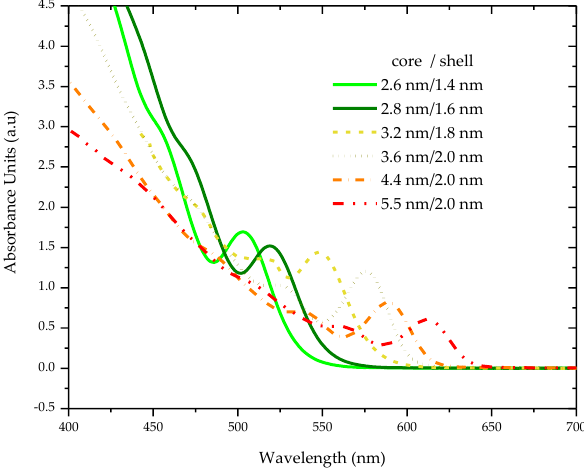
Figure 1. The absorption spectra for different sized quantum dots at a concentration of 2 mg in 5 mL of THF.